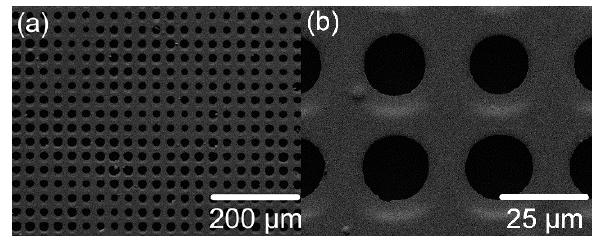
Figure 4. SEM images of a Kapton filter after heating at 350 °C for 10 minutes. The magnifications are ( a ) 200× and ( b ) 1500×.